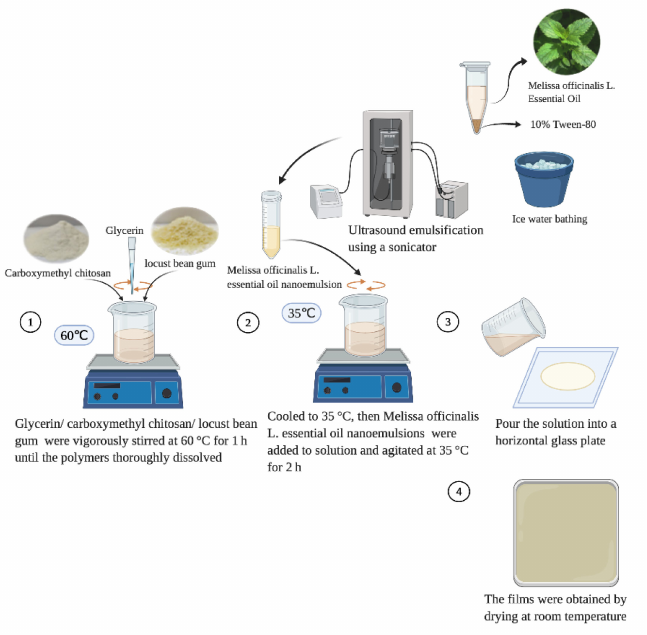
Figure 1. The preparation of carboxymethyl chitosan/locust bean gum/ Melissa officinalis L. essential oil active